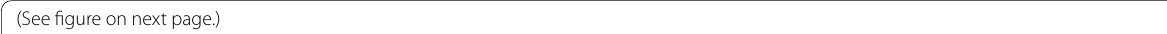
Fig. 16 Echinid and brachiopods from the Saars Formation of the Swiss Jura Mountains. 1–2: Pseudholaster intermedius (Münster in Goldfuss, 1826), same specimen in aboral (1) and oral (2) views, Falaises Member/Corcelles Marls (Early Barremian), Corcelles‑1 (NE), MGL 101599. 3–4: Glosseudesia semistriata (Defrance, 1828), Falaises Member/Corcelles Marls (Early Barremian), Corcelles‑2 (NE), collection P.‑O. Mojon. 5–9: Glosseudesia inexpectata Mojon, n. sp.; basal Montcherand Member (Early Barremian), Corcelles‑1 (NE); holotype (5–7): MGL 101598; paratypes (8–9): MGL 101598’ and 101598’’. 10–13: Glosseudesia ebrodunensis (de Loriol, 1864), Montcherand Member (Early Barremian), Eclépens quarry (VD), cf. De Kaenel et al. (2020), collection P.‑O. Mojon. Ventral views of pedicle valves (3, 5, 10, 12), lateral view (7) and dorsal views of brachial valves (4, 6, 8, 9, 11, 13) of